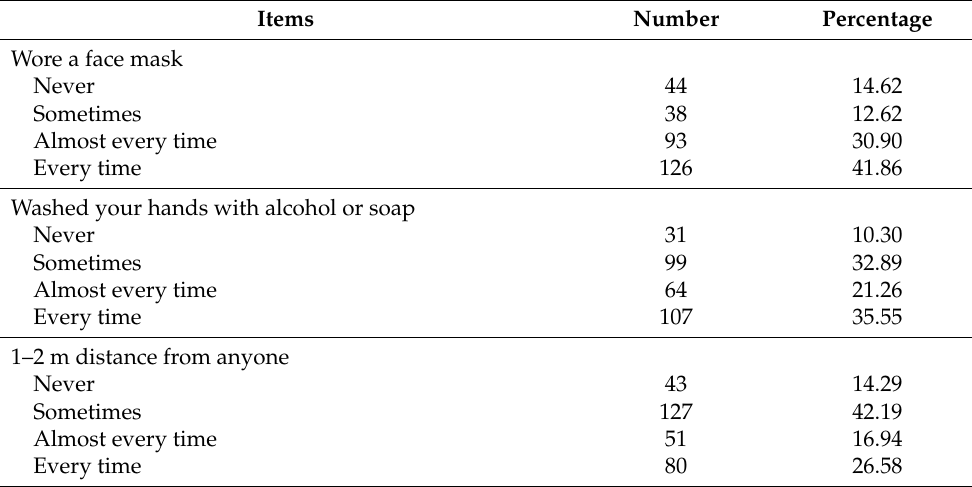
Table 2. Compliance with COVID-19 prevention social measures during the previous month (n =